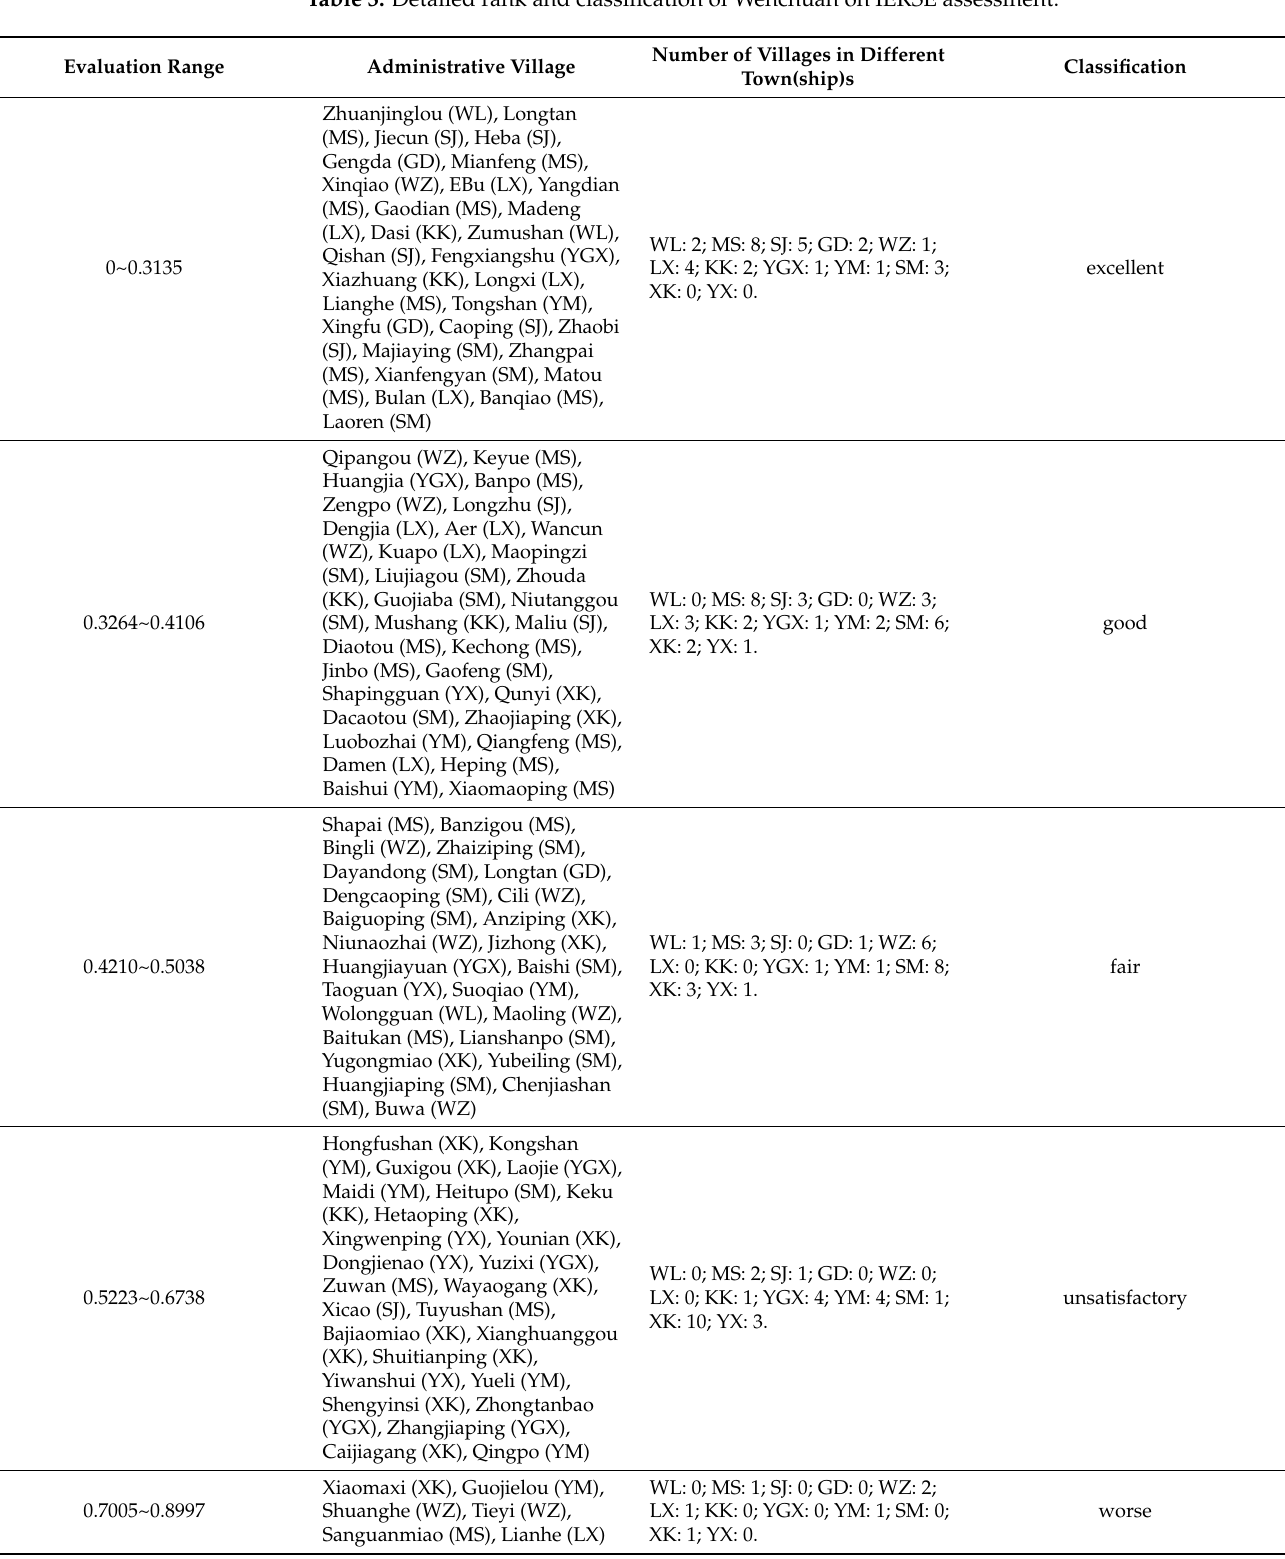
Table 3. Detailed rank and classification of Wenchuan on IERSE